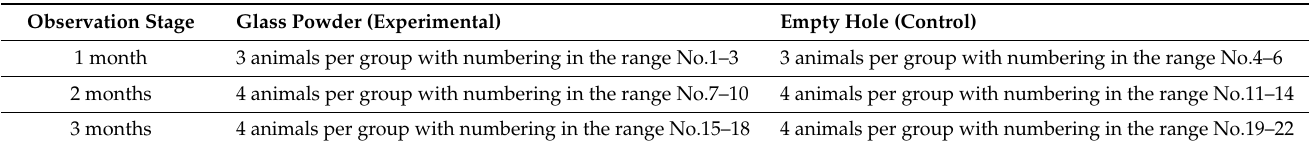
Table 1. Design of the implantation procedure.